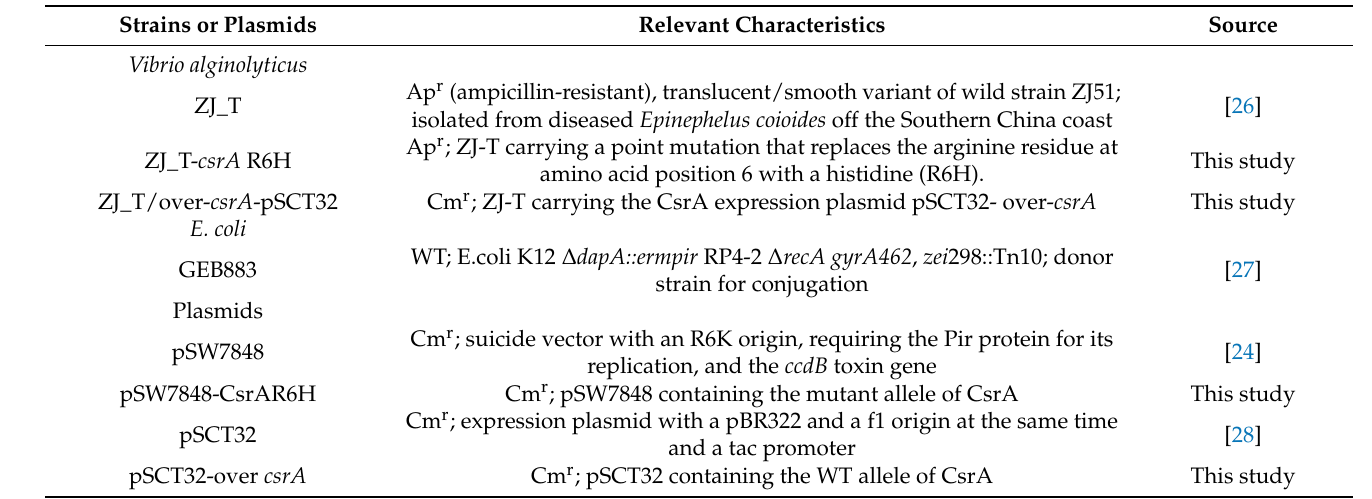
Table 1. Strains and plasmids used in this